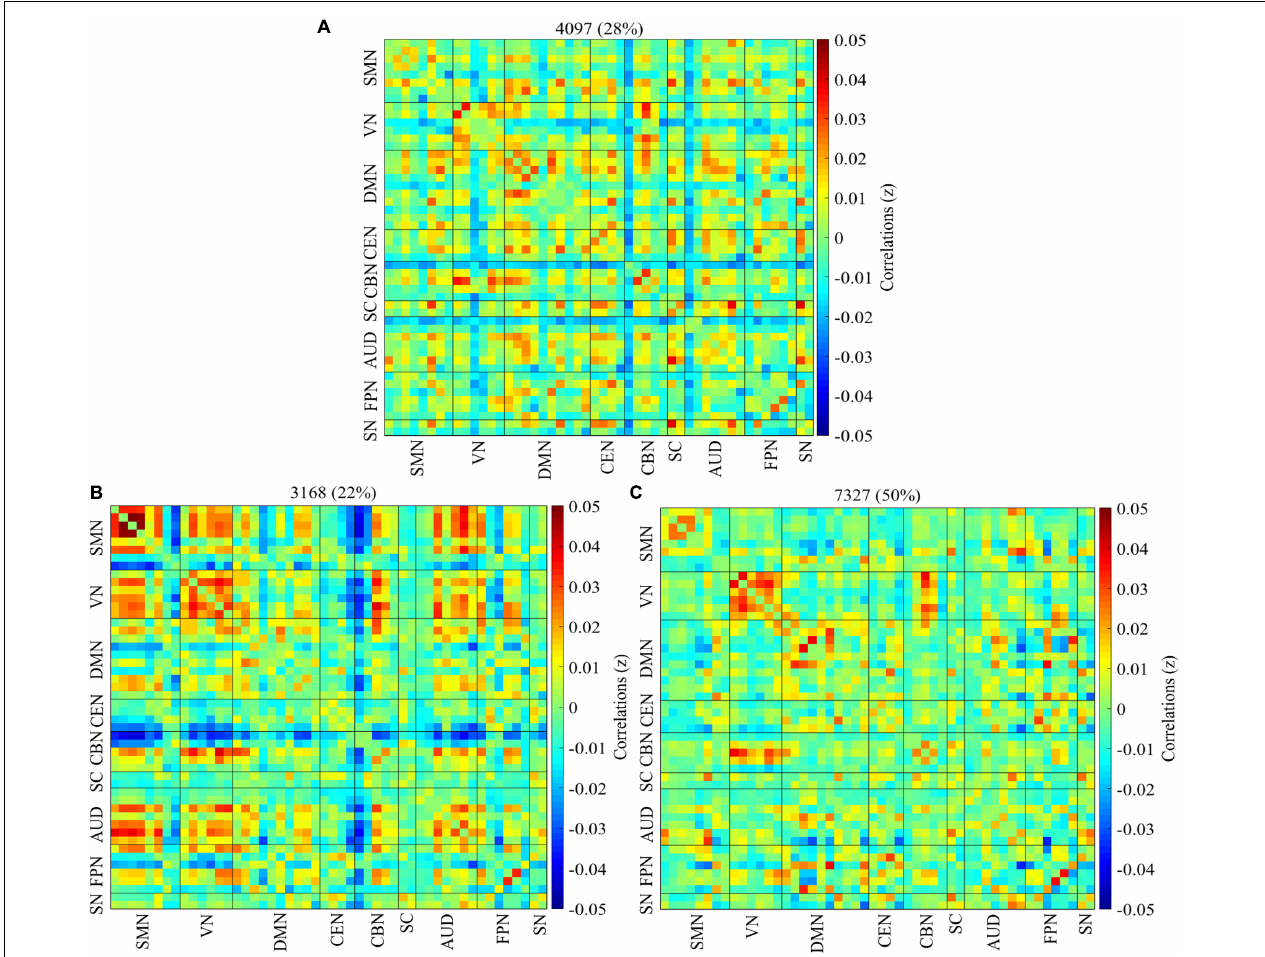
FIGURE 2 | Percentage of occurrence. The median of all subjects together with the total number and percentage of occurrences are displayed in each state. (A–C) Represent states 1–3. The connectivity pattern varies among the three cluster states with state 2 showing more connectivity than states 1 and